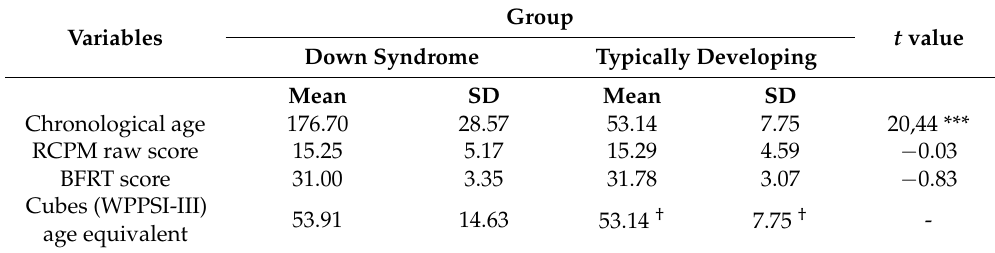
Table 1. Characteristics of Raven’s Colored Progressive Matrices (RCPM) Matched